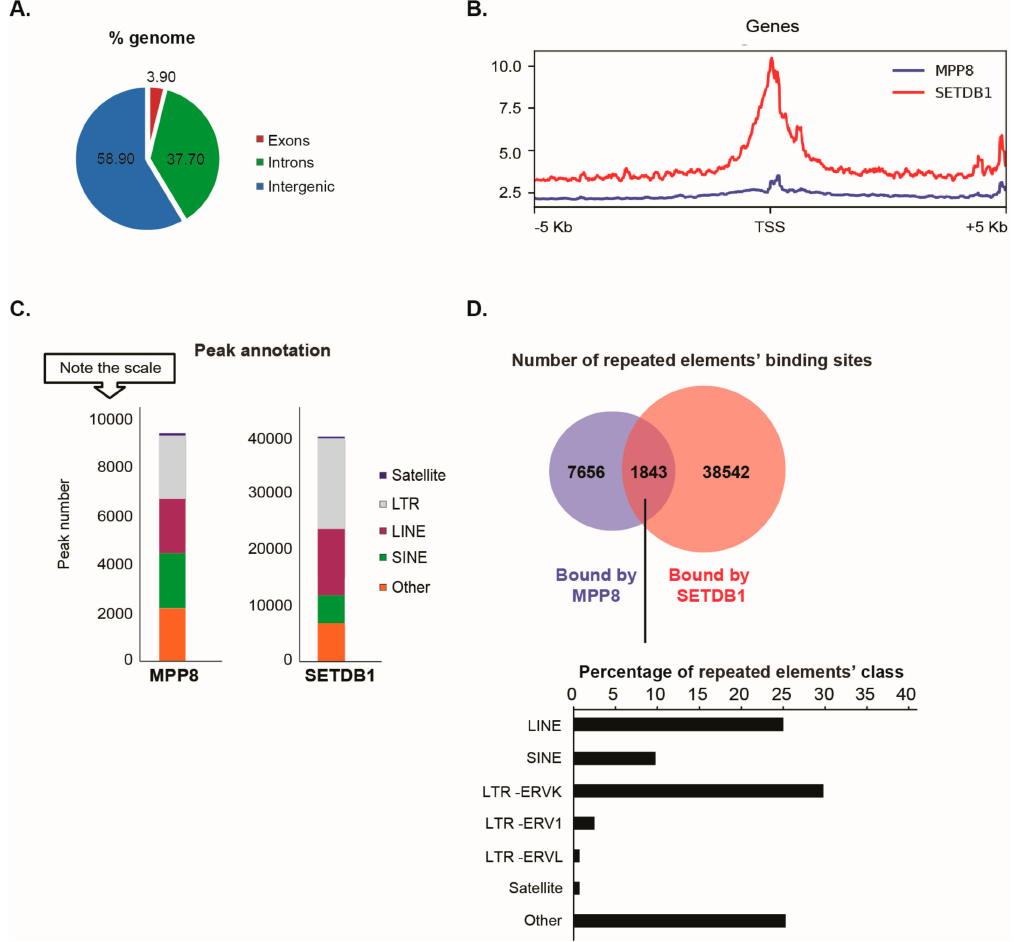
Figure 2. MPP8 and SETDB1 occupy common genes and repetitive elements genome-wide in mouse ESCs. ( A ) Venn Diagram of the genome-wide distribution of MPP8 binding sites in mESCs. ( B ) Global SETDB1 occupancy over MPP8 binding sites in mESCs. The graph represents average binding density of genomic regions surrounding ( ± 5 kb) MPP8 and SETDB1 binding sites in mESCs. ( C ) Distribution of MPP8 and SETDB1 annotated peaks for the main families of retrotransposons in mESCs. Data represent the number of annotated peaks. ( D ) Venn diagram representation of transposable elements enriched in the binding sites of MPP8 and SETDB1 in mESCs. For co-bound sites, a representation of distribution of repeated elements’ classes is shown in